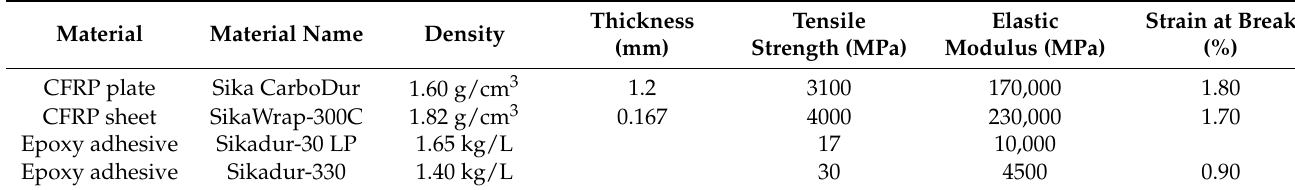
Table 3. Mechanical properties of CFRP sheet, CFRP plate, and epoxy